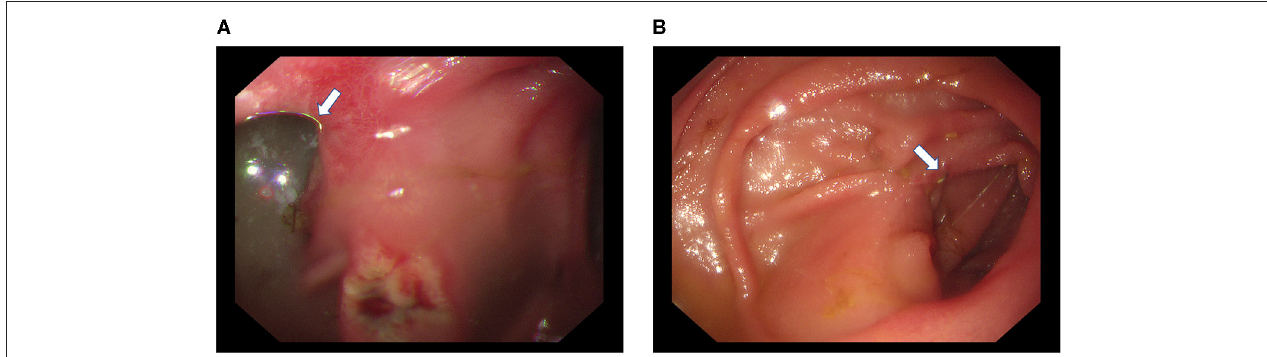
FIGURE 4 | Gastroscopy of one patient with recanalization. Bile reflux (white arrow) through the afferent limb and a stomal ulcer were detected during endoscopy (A) . The residual staplers (white arrow) remained in the mucosa of the afferent limb (B)